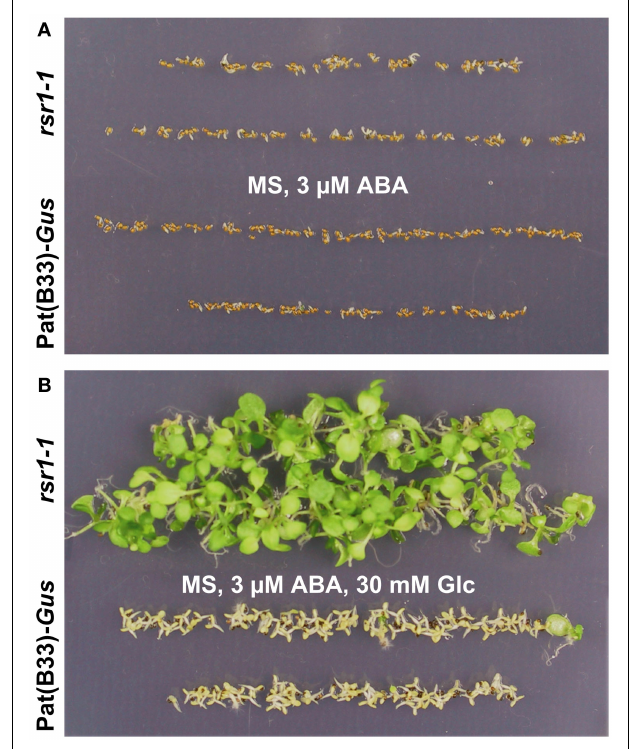
FIGURE 4 |Abscisic acid (ABA)-insensitivity of rsr1-1 is Glc-dependent. Seeds of rsr1-1 (upper lanes) and Pat(B33)- Gus (lower lanes) were plated on MS-medium supplemented either with (A) 3 μ M ABA or (B) 3 μ M ABA + 30mM Glc. In the presence of both Glc and ABA, rsr1-1 seedlings had developed chlorophyll and primary leaves 4weeks after plating, whereas 3 μ M ABA alone delayed germination and completely inhibited development in both rsr1-1 and Pat(B33)- Gus